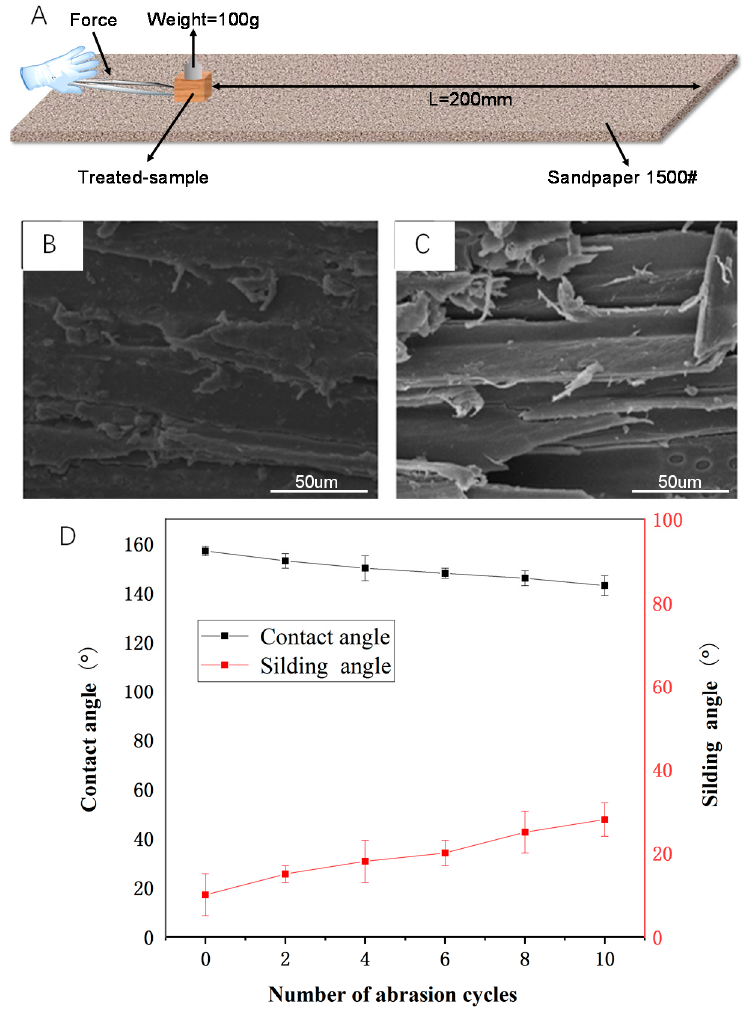
Figure 14. Abrasion resistance of PDMS@wood. ( A ) Schematic of the illustration of the sandpaper abrasion test. ( B ) The SEM image of the PDMS@wood surface before abrasion test. ( C ) The SEM image of the PDMS@wood surface after abrasion test. ( D ) The water CA and SA as a function of number of abrasion cycles for hydrophobic wood surface.